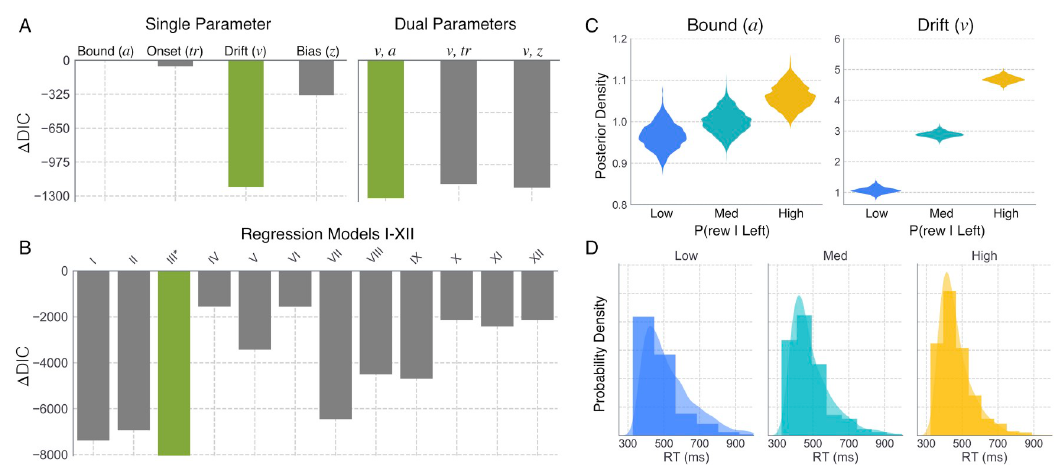
Fig 7. Model comparison and fits to randomly sampled network data. A. Δ DIC values for all single (left) and dual (right) free parameter models. B. Δ DIC values for DDM regression models I − XII associated with parameters ( v , a ). C. Posterior distributions for boundary height ( a ) and drift rate ( v ) estimated in the best-fitting regression model III. D. Correct RT distributions generated by the sampled networks (histograms) with predicted distributions from regression model III overlaid as kernel densities for each reward condition (see Fig 5 for corresponding model fit results from original network